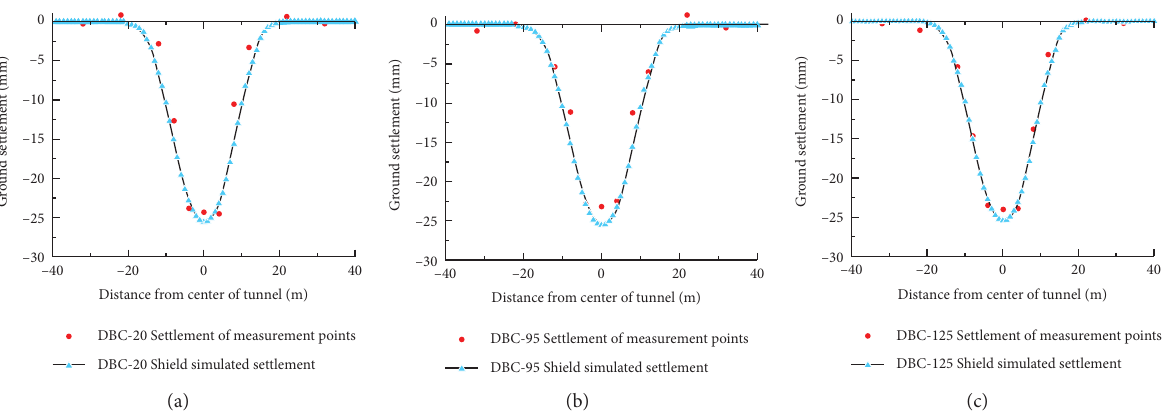
Figure 11: Final ground surface settlement of shield field measurement: (a) DBC-20. (b) DBC-95. (c)